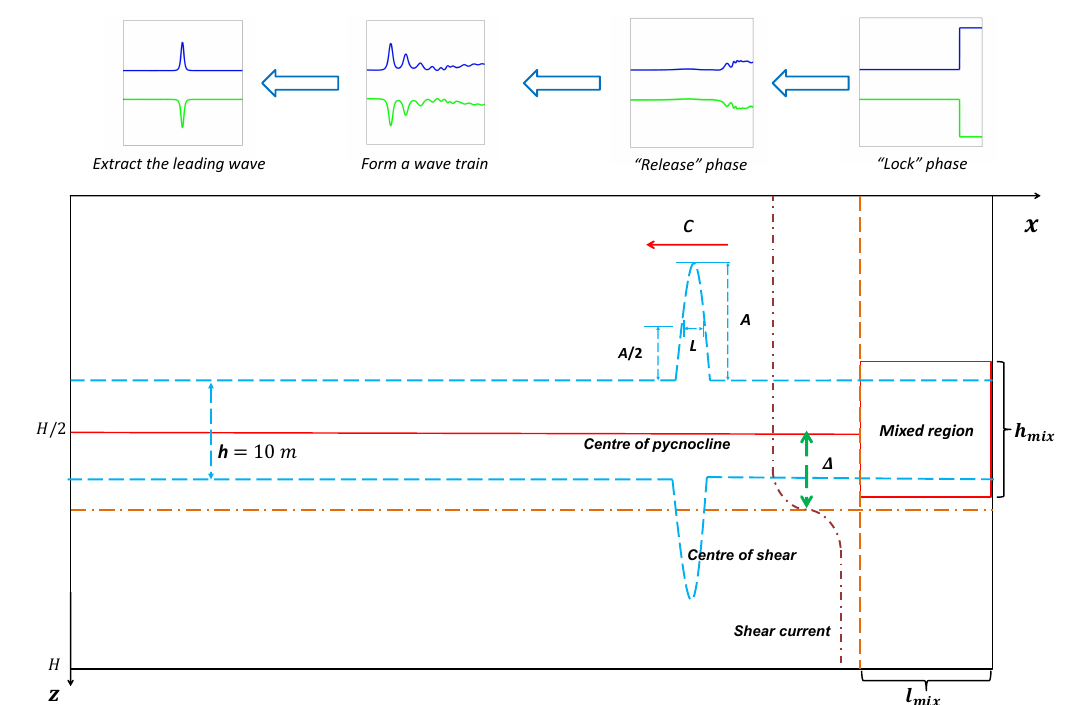
Figure 2. Schematic diagram of the model configuration and initialization, where (cid:49) denotes the asymmetry parameter, h denotes the thick- ness of the pycnocline, c , A , and L indicate the propagation speed, amplitude, and wavelength of a mode-2 ISW, h mix and l mix denote the height and length of the mixed region, and H indicates the depth.